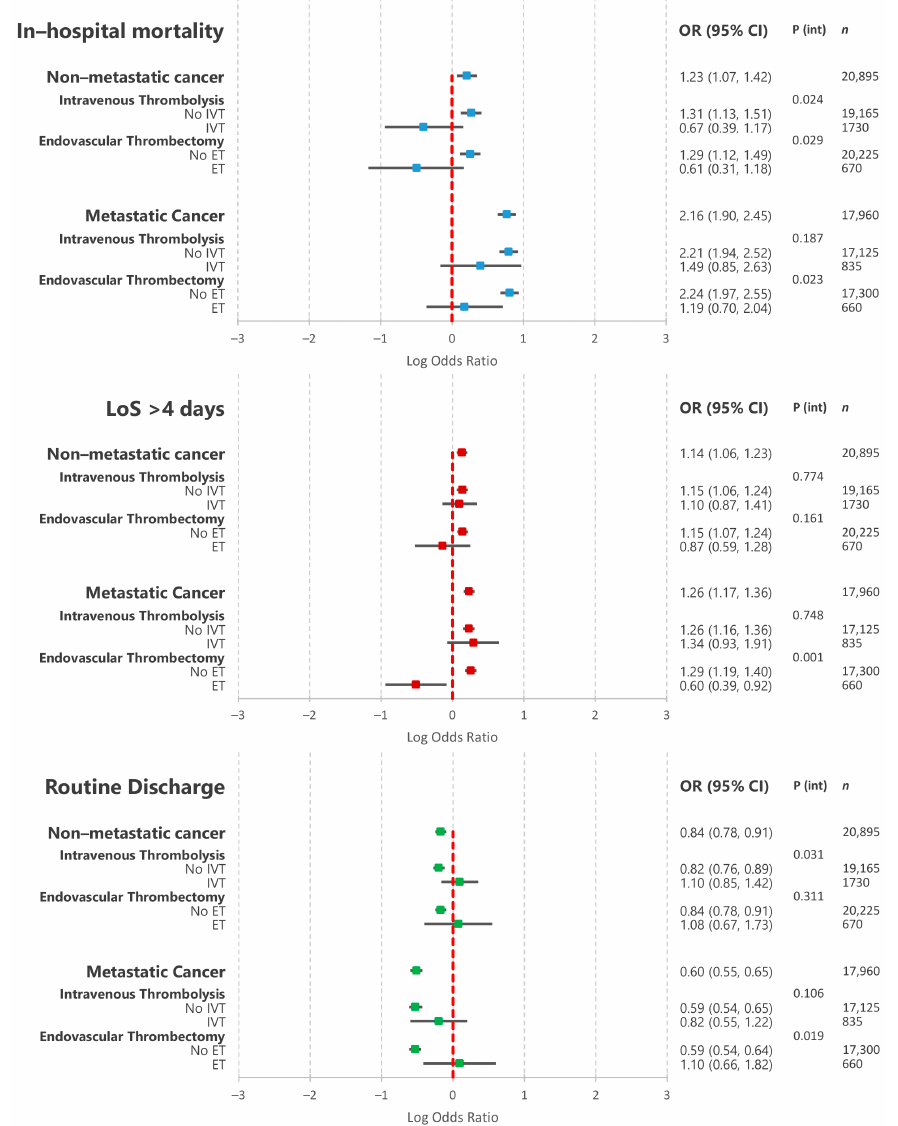
Figure 3. Results of multivariable logistic regressions assessing the association between co-morbid cancer (non-metastatic and metastatic) and acute ischaemic stroke in-hospital outcomes as well as the interaction with revascularisation therapies. OR—odds ratio; CI—confidence interval; IVT—intravenous thrombolysis; ET—endovascular thrombectomy; P (int)— p value for interaction term.